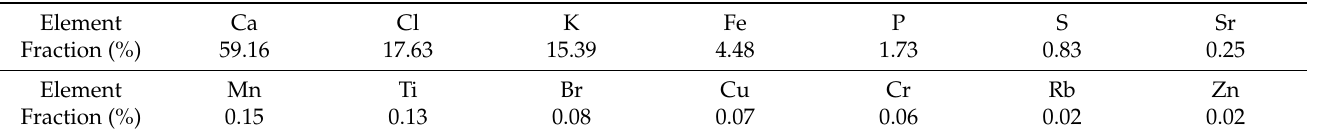
Table 2. Food-waste-biochar